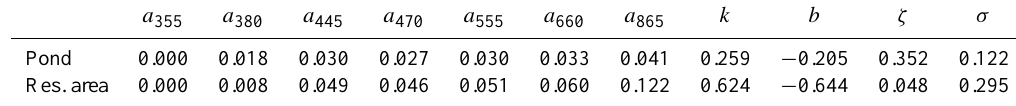
Table 2. Surface parameters retrieved from fitting the AirMSPI data over the Fresno pond and residential area targets.